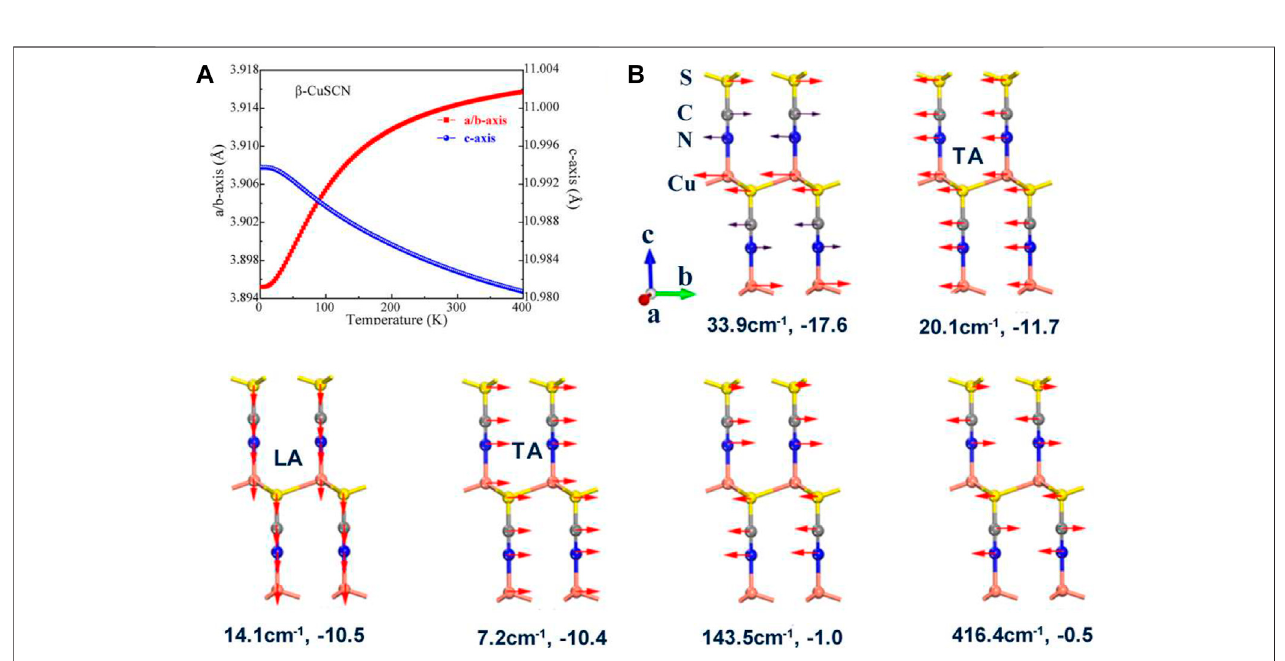
Frontiers in Materials |